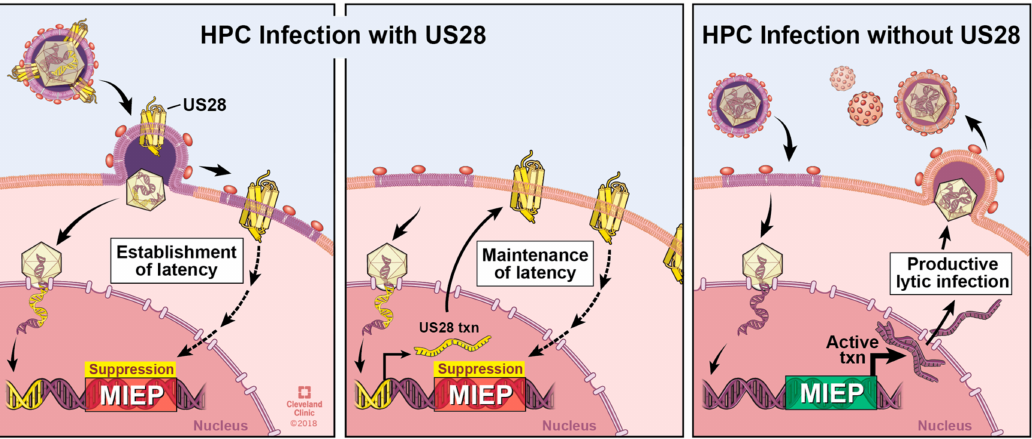
Figure 3. pUS28 contributes to latent infections. Left & Middle Panels: WT infection of HPCs results in a latent infection. Left Panel: pUS28 (yellow barrels) is incorporated into the virion and is delivered upon infection [52]. Virion-delivered pUS28 aids in suppressing transcription (txn) from the MIEP [111,113], by an as of yet unidentified mechanism (dashed arrows). Middle panel: Sustained pUS28 expression throughout infection of HPCs is required for continued suppression of the MIEP, due at least in part through attenuation of MAPK and NF κ B (dashed line; [56]). Right panel: When the ORF encoding US28 is deleted from the viral genome, infection of HPCs results in a lytic, rather than latent infection